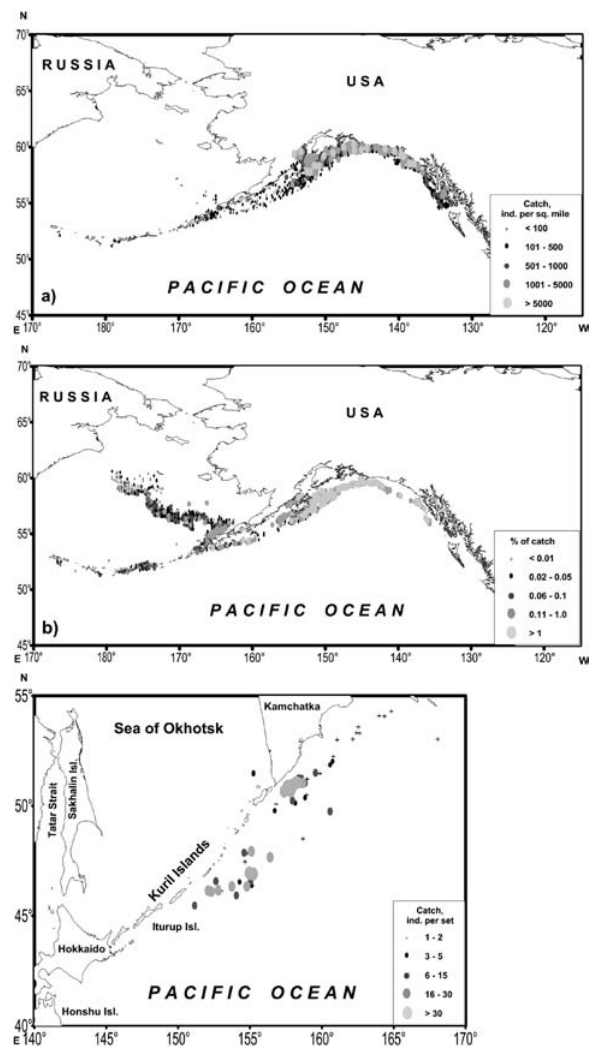
Fig . 2. – Distribution and relative abundance of Squalus suckleyi in the northeastern Pacific based on data of AFSC bottom trawl sur- veys (a) and US observers on board commercial fishing vessels (b) and in the Pacific off the Kuril Islands and Kamchatka based on the data of Russian observers of salmon driftnet fisheries